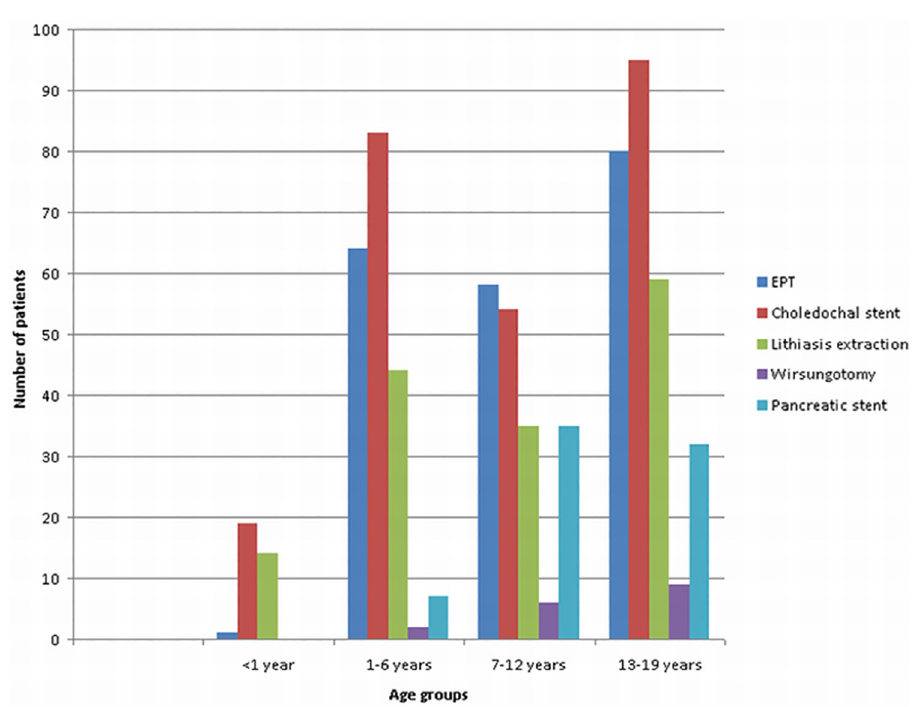
Fig 4. Endoscopic therapeutic procedures stratified by age—Absolute numbers.